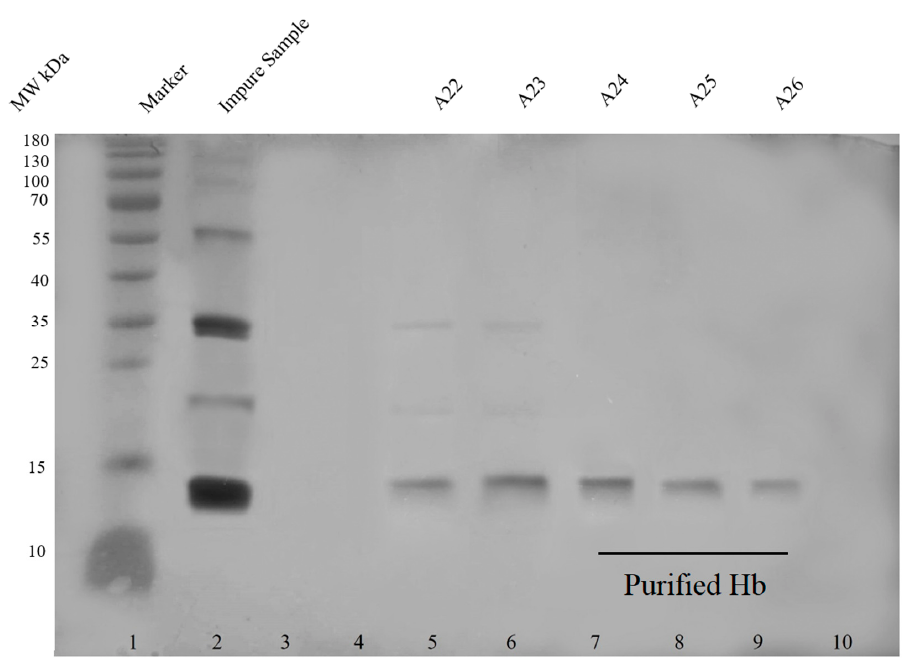
Figure 3. Purification of hemoglobin through anion exchange chromatography. Silver stained SDS PAGE gel (12%) (uncropped single gel) showing hemoglobin before and after purification. The impure sample showed multiple bands of impurities. Impurities were also observed in fractions A22 and A23. Hemoglobin was completely purified in fractions A24–A26. The color image of the complete gel is shown in Appendix Figure A6.